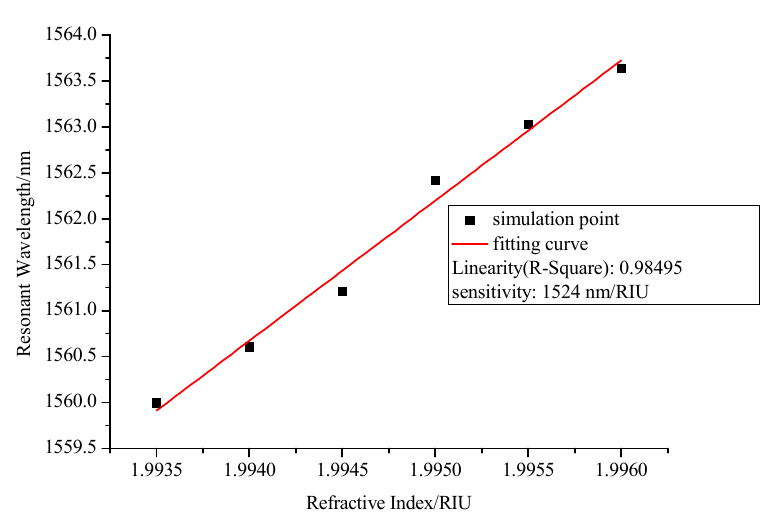
Figure 5. Relationship between resonant wavelength and refractive indices when the length of NCF is 4 cm.